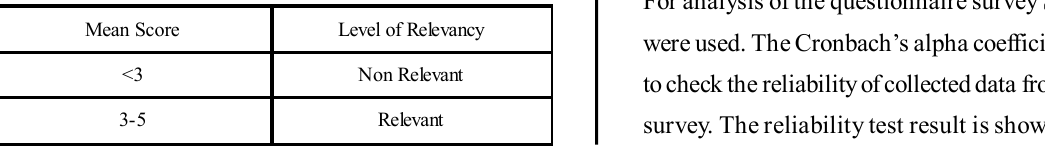
TABLE 1. CUT OFF SCALE OF CAUSES OF CONSTRUCTION